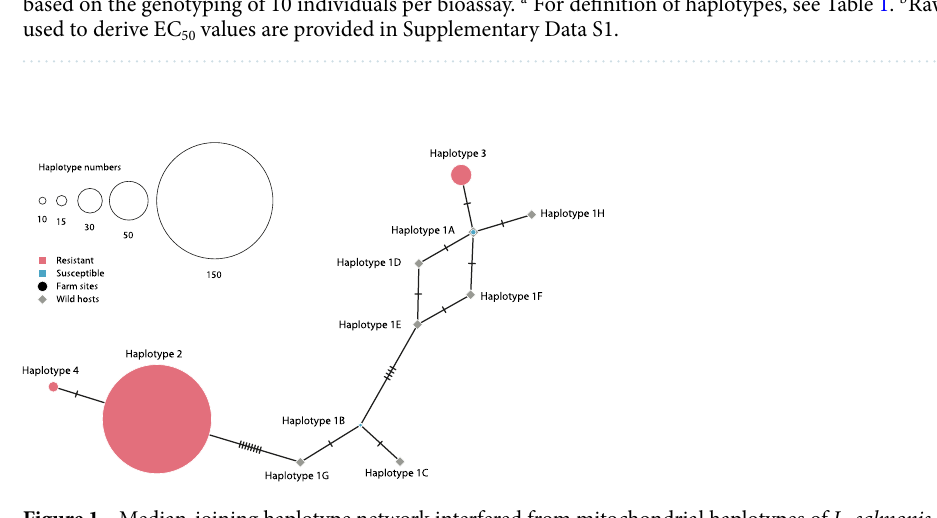
Figure 1. Median-joining haplotype network interfered from mitochondrial haplotypes of L. salmonis . Haplotypes were defined based on the combined occurrence of 18 mitochondrial SNPs, which have been associated with deltamethrin resistance in L. salmonis in a previous study 21 (Supplementary Tables S8 and S9). Haplotypes that were identified in salmon lice from farm sites are represented by circles, while haplotypes that were identified in salmon lice from wild hosts are represented by grey rhombi. The size of each circle is proportional to the frequency of each haplotype in salmon lice from farm sites. Deltamethrin resistance associated haplotypes are represented by red circles and susceptibility-associated haplotypes are shown in